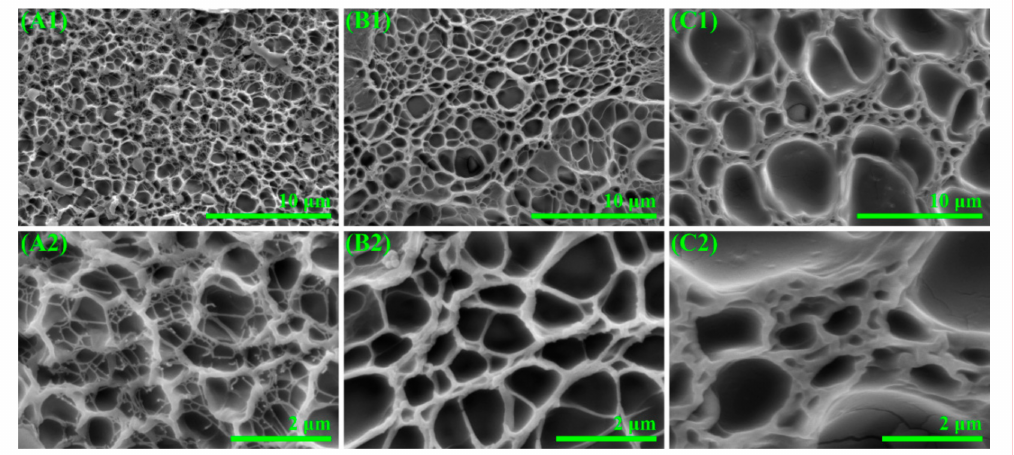
Figure 2. Broken sections of CDN-gels. ( A1 , A2 ) GEL-0; ( B1 , B2 ) GEL-0.5; ( C1 , C2 )